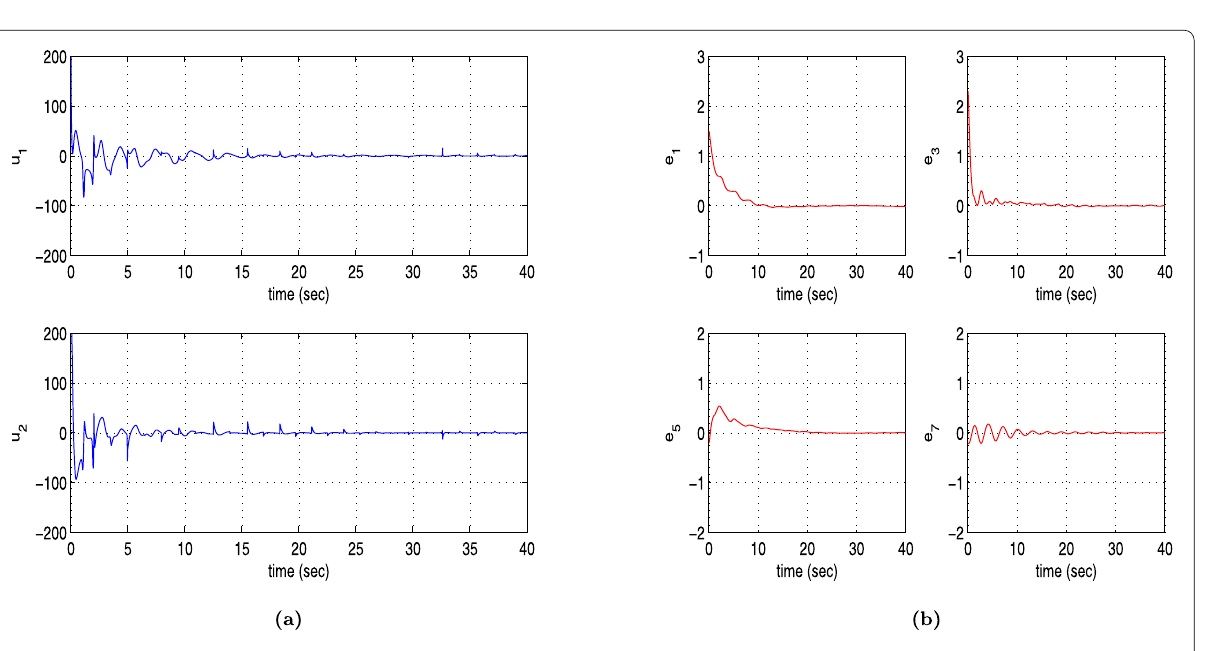
Figure 16 Tracking of setpoint 7 for the tower crane ( a ) control inputs u 1 , u 2 applied to crane, ( b ) tracking error variables e 1 , e 3 , e 5 , e 7 of the tower